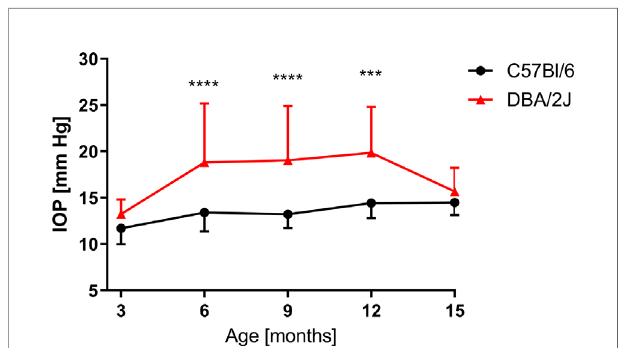
FIGURE 5 | Intraocular pressure (IOP) measured for DBA/2J (3 months, n = 12; 6 months, n = 40; 9 months, n = 34; 12 months, n = 38; 15 months, n = 42), for C57BL/6J (3 months, n = 17; 6 months, n = 27; 9 months, n = 14; 12 months, n = 14; 15 months, n = 19). Two-way ANOVA and post hoc Sidak ’ s test: ***P < 0.001, ****P < 0.0001. Means and SD (for the sake of clarity, error bars are drawn only above, for DBA/2J, or below, for C57Bl/6, the point representing mean